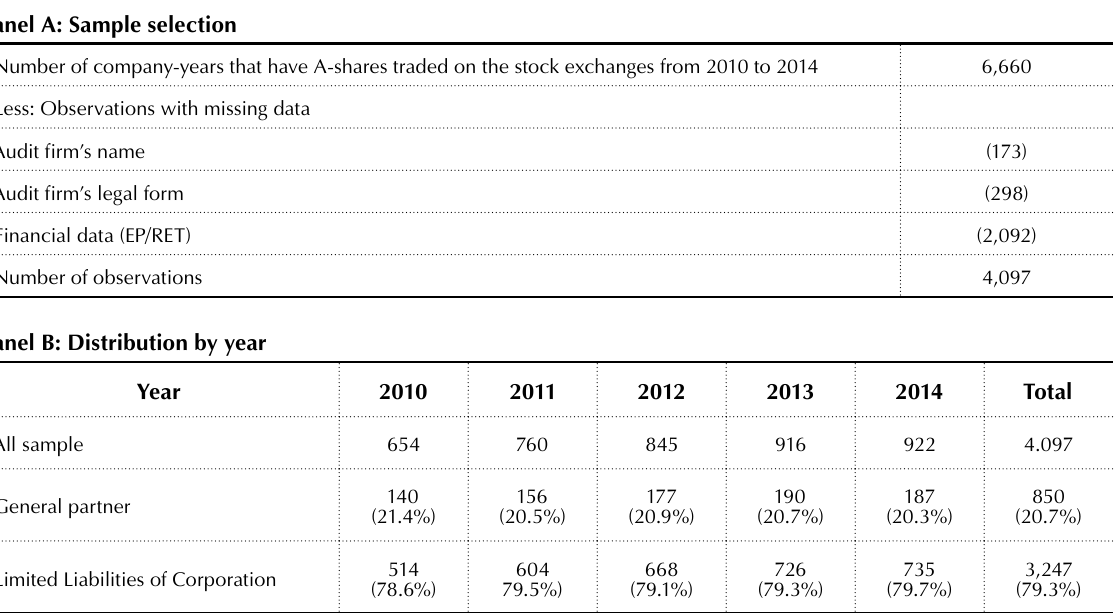
Table 1. Sample selection and distribution of audit firm legal